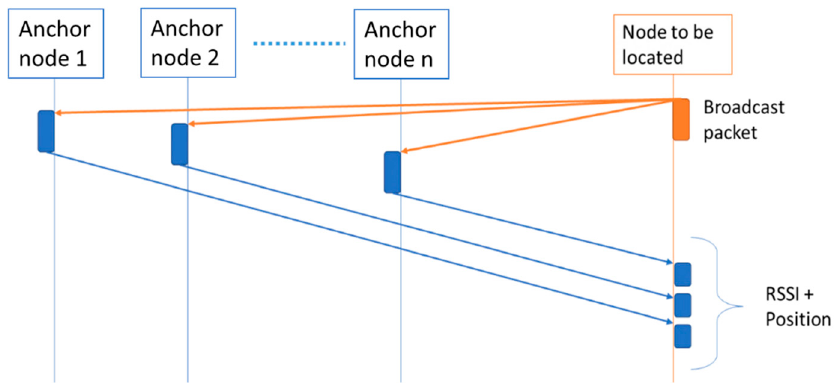
Figure 15. Communication between nodes.